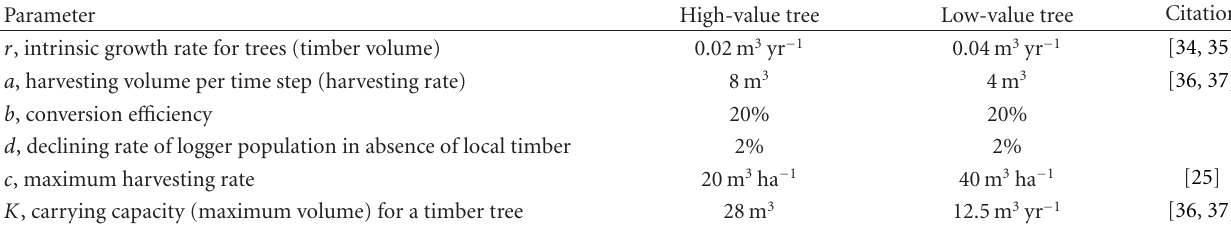
Table 1: Summary of parameters for the Lotka-Volterra component of the